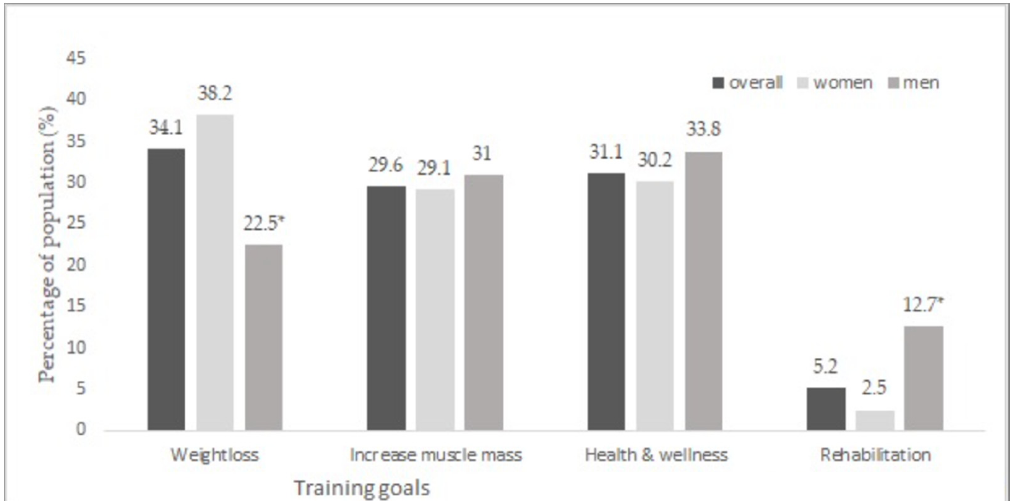
Figure 3. Training goals by gender.